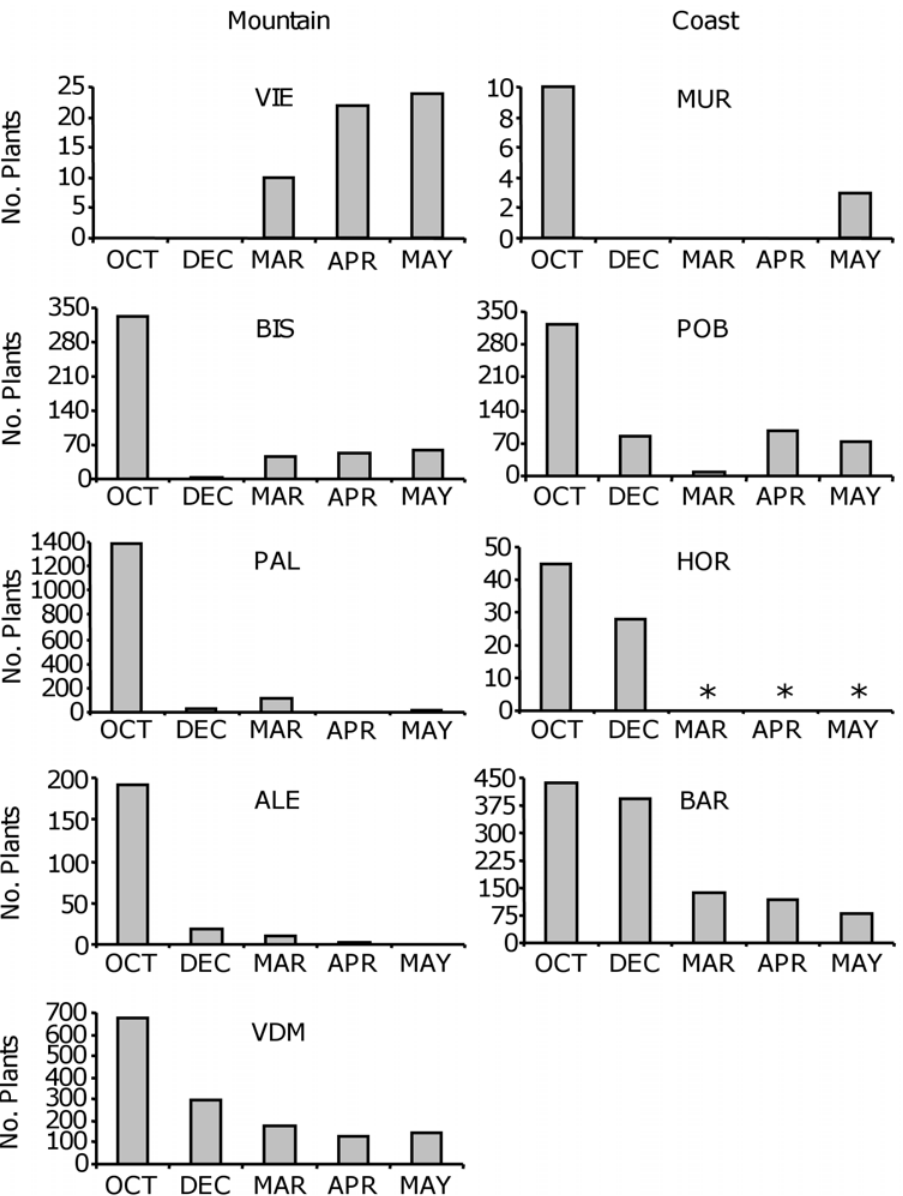
Figure 5. Total number of plants per population over time. The different panels show the number of plants per population and survey (October 2007, December 2007, March 2008, April 2008, and May 2008) for montane and coastal A. thaliana populations. Asterisks indicate that data were not available at HOR because the site was destroyed in late winter. Populations are ranked according to their altitude within each region.